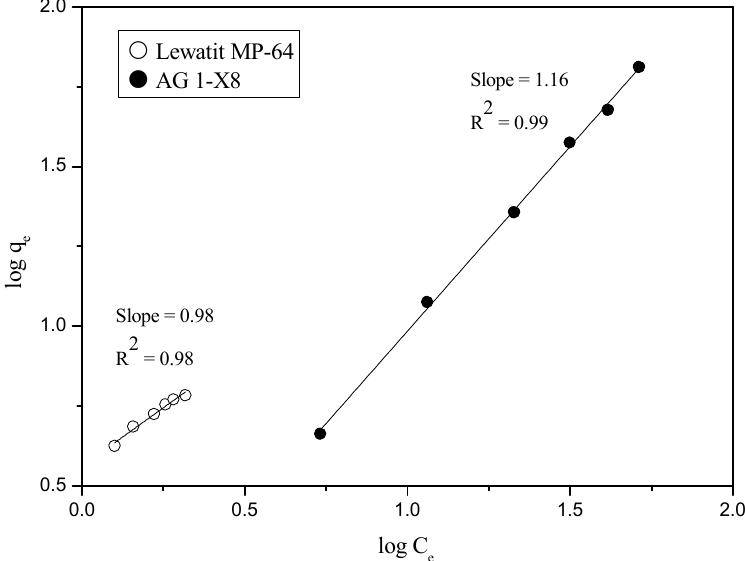
Figure 10. Verification of Freundlich isotherm for the adsorption of Ru(III) onto AG 1-X8 and Lewatit MP-64.